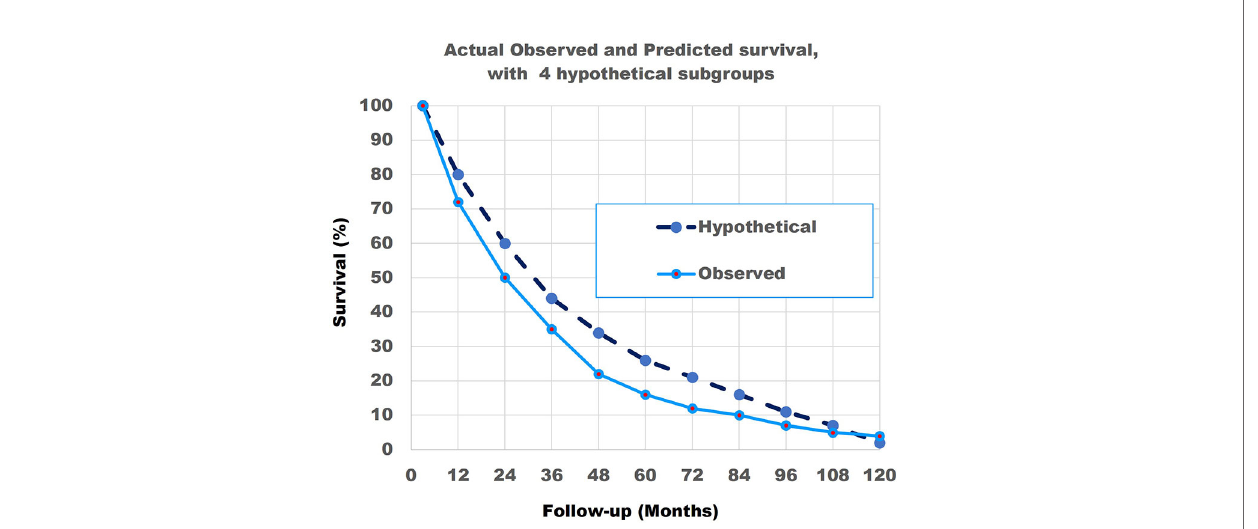
FIGURE 10 | The actual observed survival curve (light blue continuous line) with the results of the combination of the model with 4 hypothetical straight lines (dark blue broken line). Note that the match is not